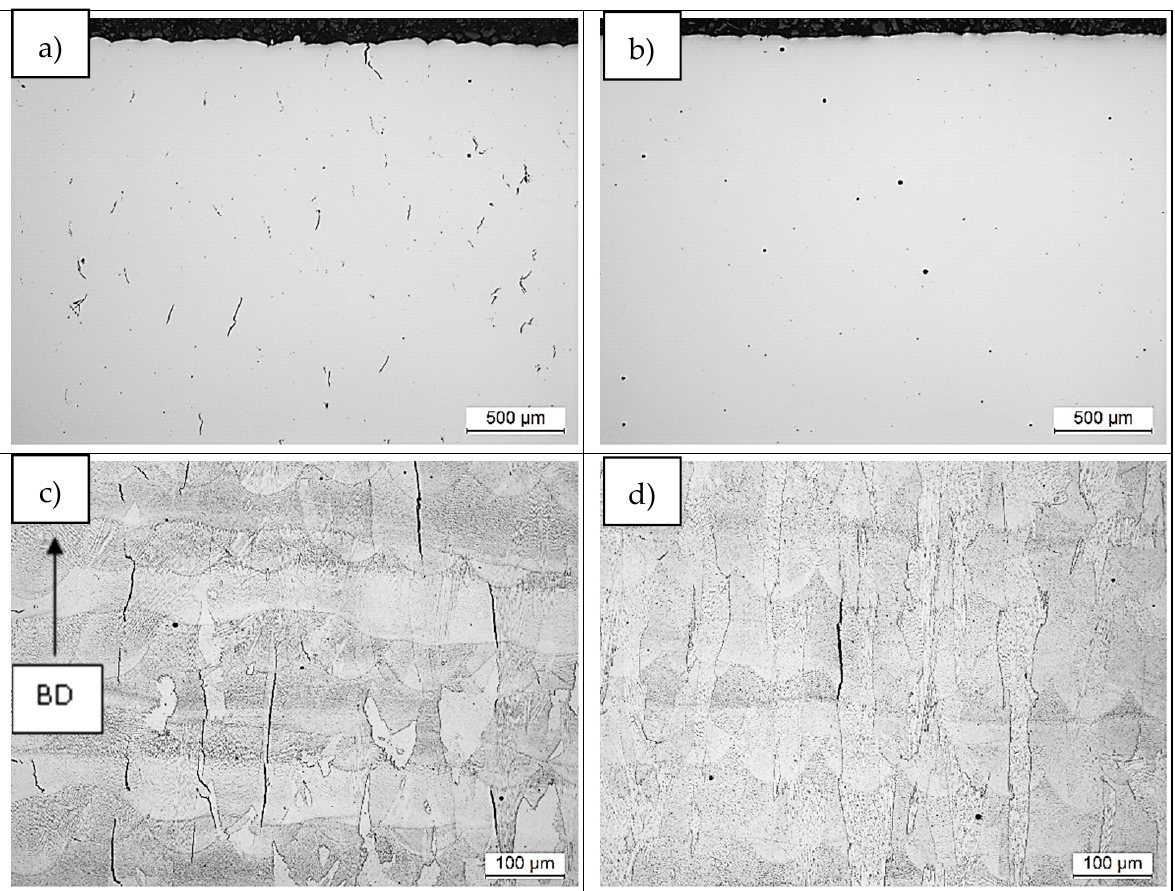
Figure 3. X–Z plane of both samples: ( a , c ) LPW and ( b , d ) A&D .